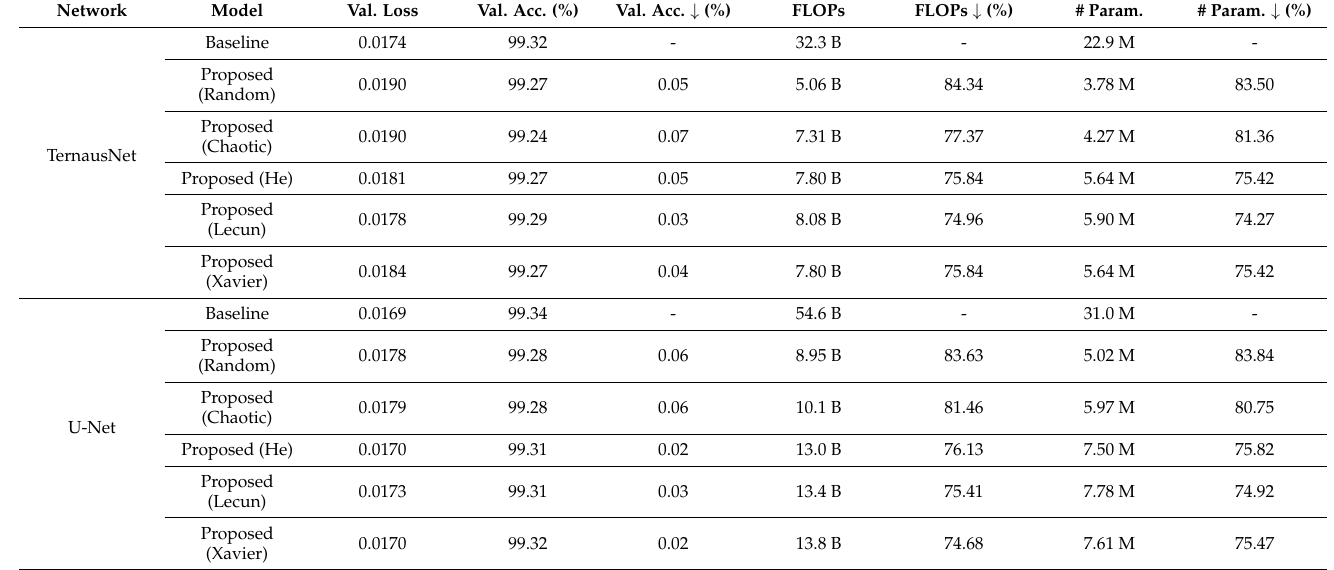
Table 3. Results on AIRS dataset. “Baseline” represents the normal training results, i.e., without pruning. “ ↓ ” represents the reduction